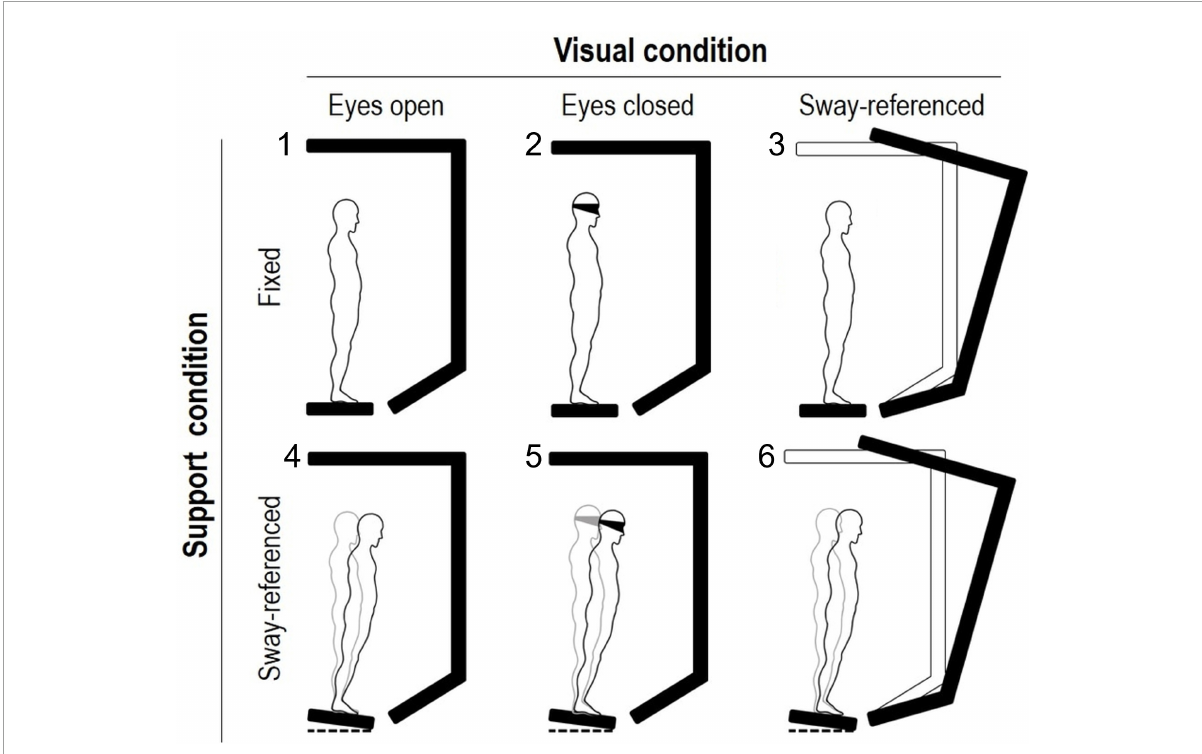
FIGURE1 Experimental setup of the sensory organization test (EquiTest system). Two support and three visual conditions (figure’s rows and columns, respectively) are combined to obtain the six balance tasks of the sensory organization test. In the sway-referenced condition, the platform and/or the screen move in the sagittal plane after the whole-body center of mass oscillation. Keeping balance is more and more challenging from conditions 1 (eyes open, fixed) to 6 (eyes open with sway-referenced screen and sway-referenced platform). Three 20-s trials are completed in each of the six